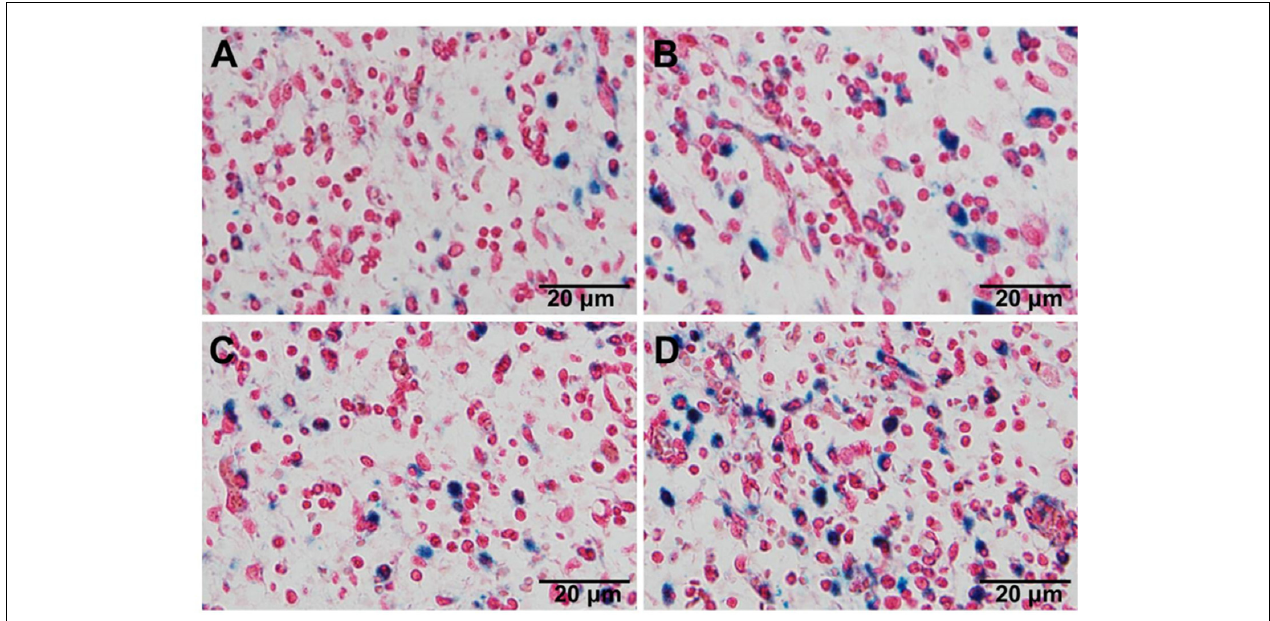
FIGURE 7 | The distribution of nanoparticles in tumor section visualized by Prussian blue staining. Histological sections were extracted at 2 h after intravenous injection of NP-SPION/PTX (A) , NP-SPION/PTX with magnetic field (B) , Pep-NP-SPION/PTX (C) , and Pep- NP-SPION/PTX with external magnetic field (D) .